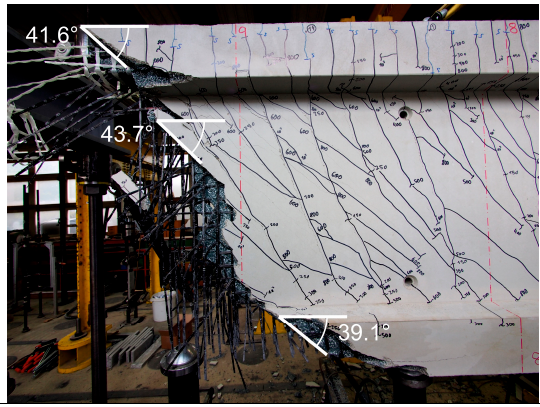
Figure 9. Failure of shear strut in compression near the support of FT02.